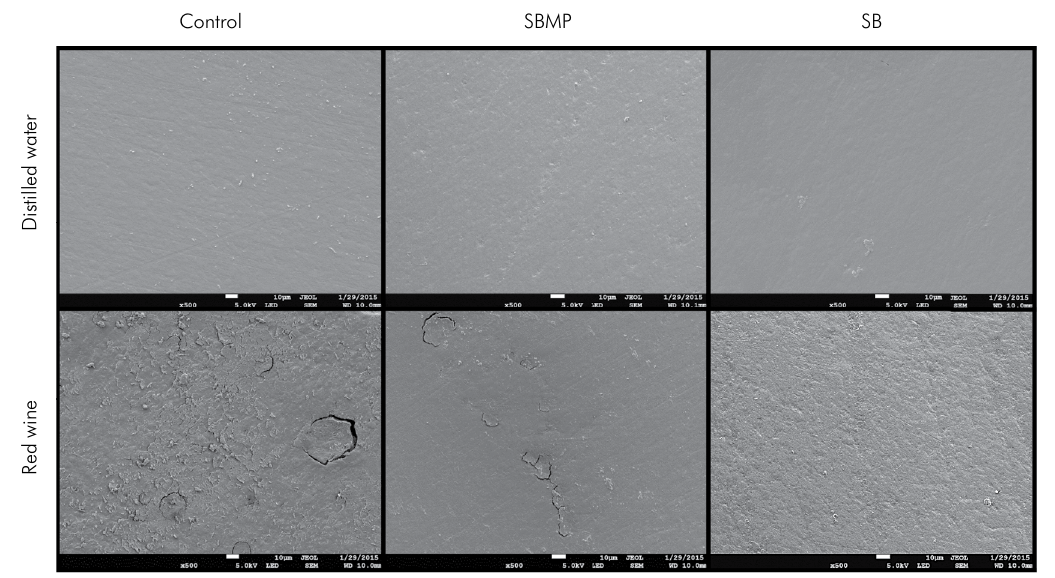
Figure 2. SEM micrographs showing the surface topography of specimens prepared with (SBMP and SB) or without (control) modeling liquid after 12 months of distilled water or red wine